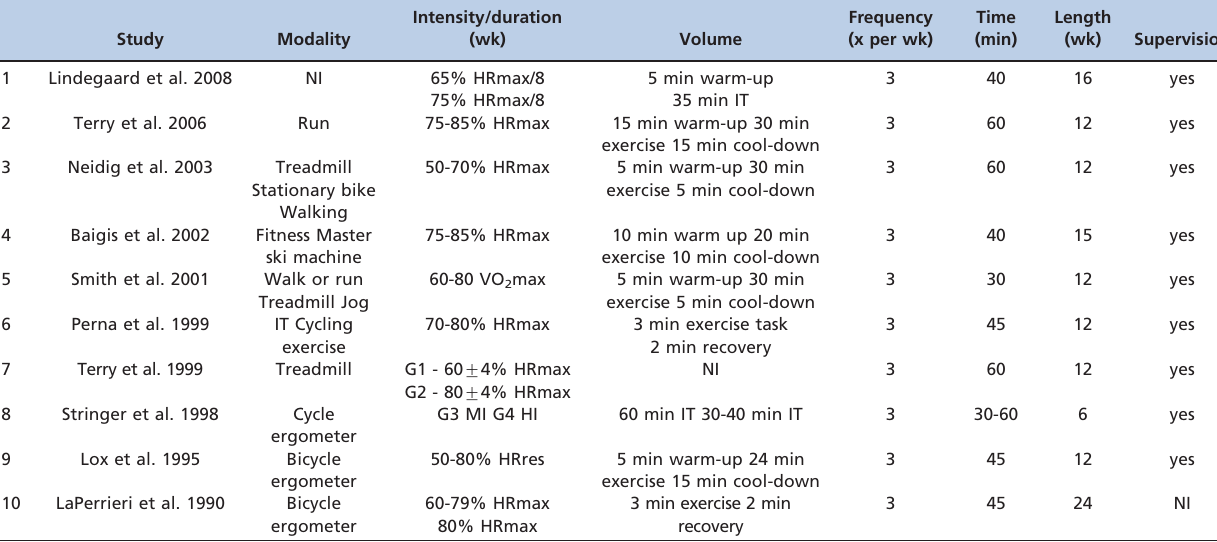
Table 4 - Characteristics of the experimental intervention (aerobic exercise) in the trials included in the